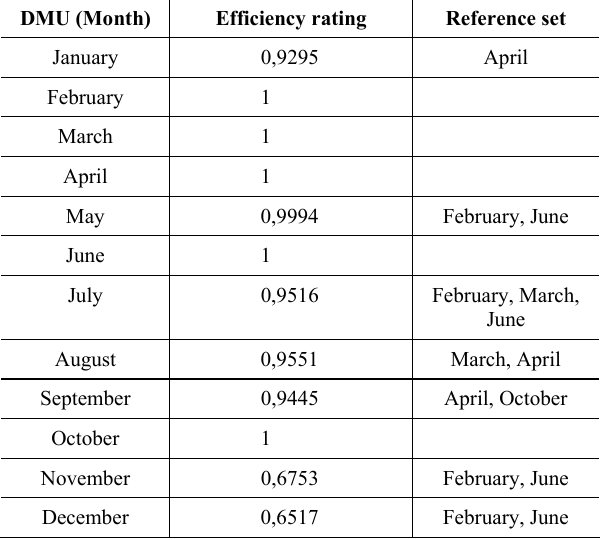
Table 4: Audit office efficiency